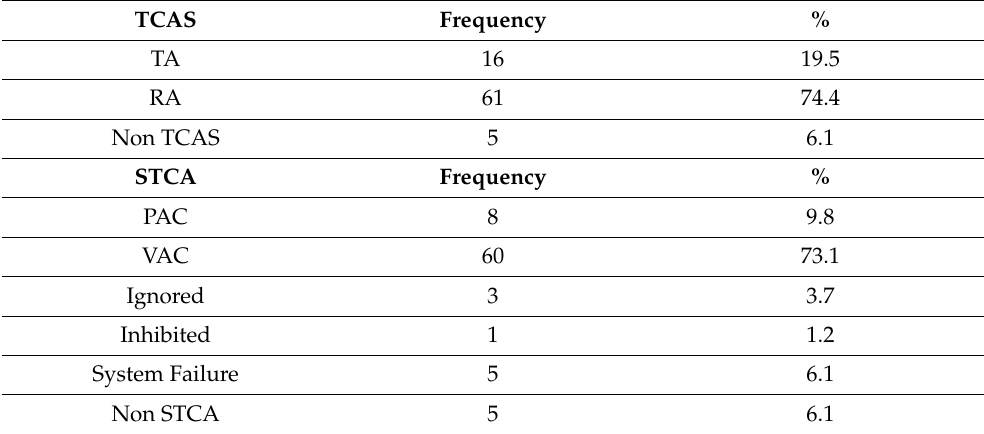
Table 3. Frequency distributions for qualitative variables which describe the safety nets behavior.